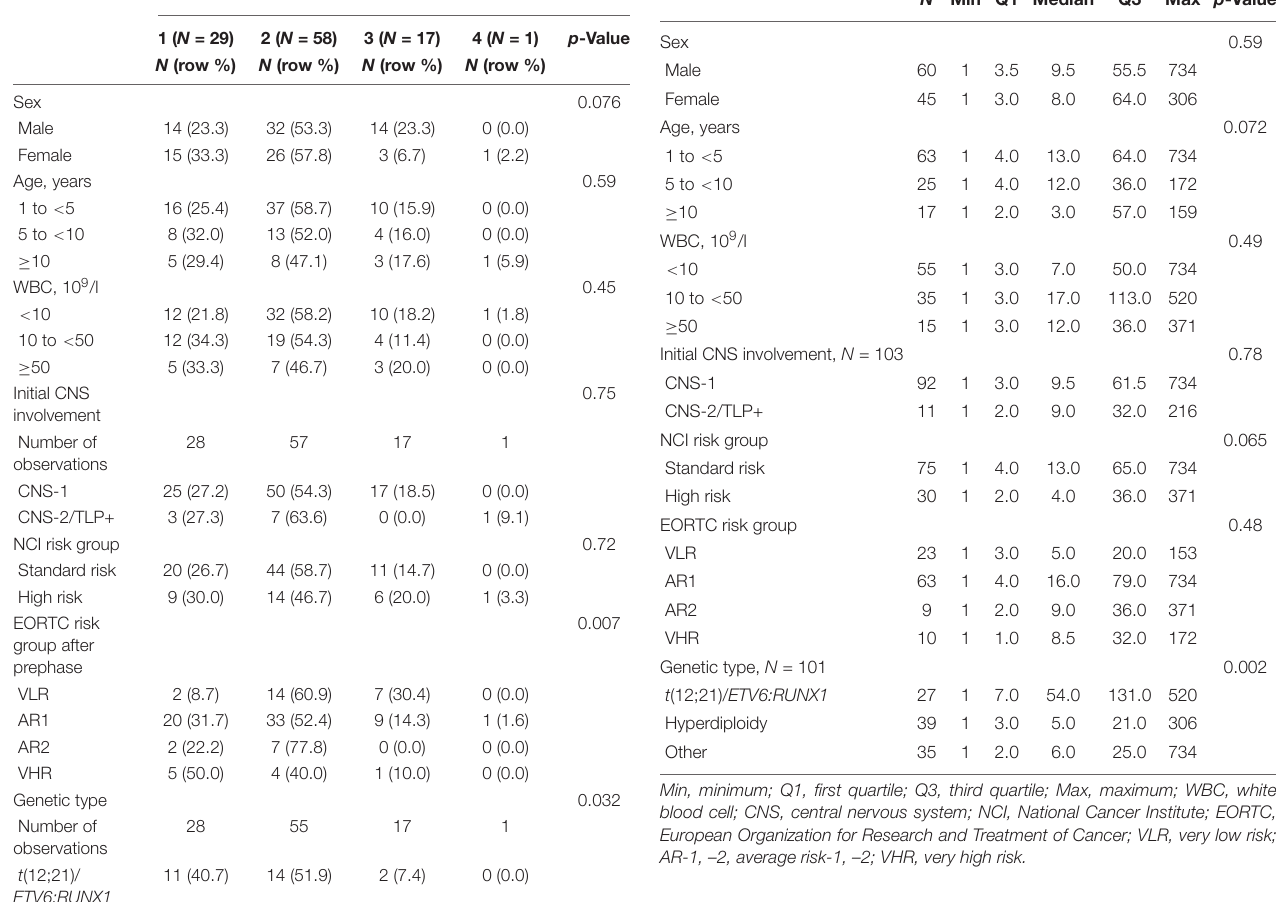
TABLE 3 | Associations between the number of foster clones and patients’ characteristics. Number of foster clones